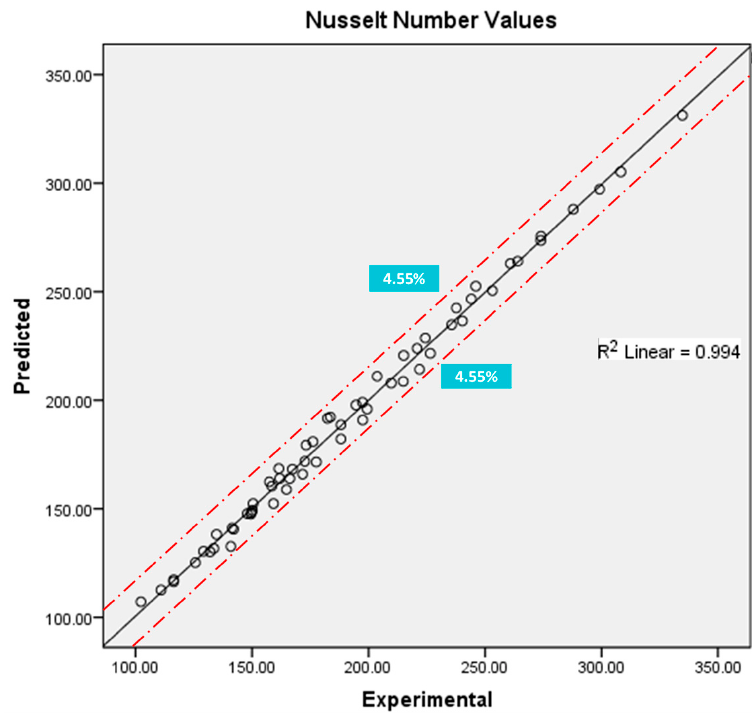
Figure 10. Validation of proposed regression model with the experimental data.